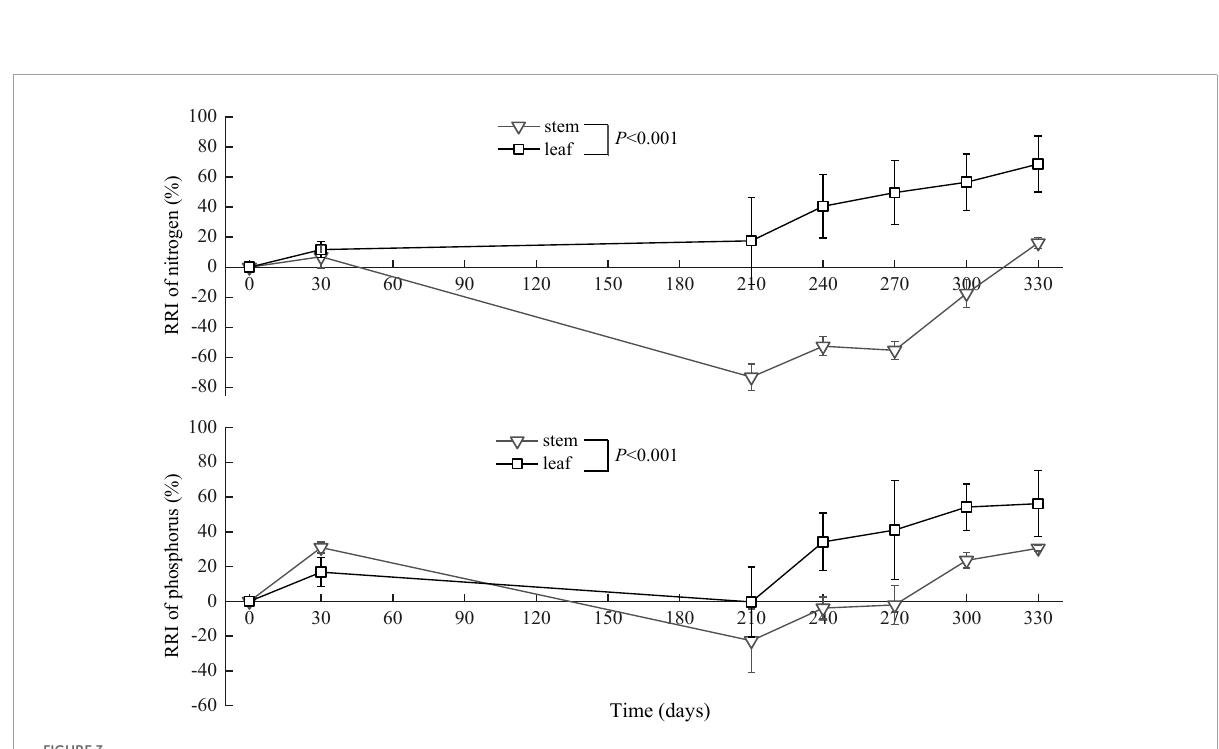
FIGURE3 Dynamics of relative release indices (RRI, means ± SD) of nitrogen and phosphorus in the in situ